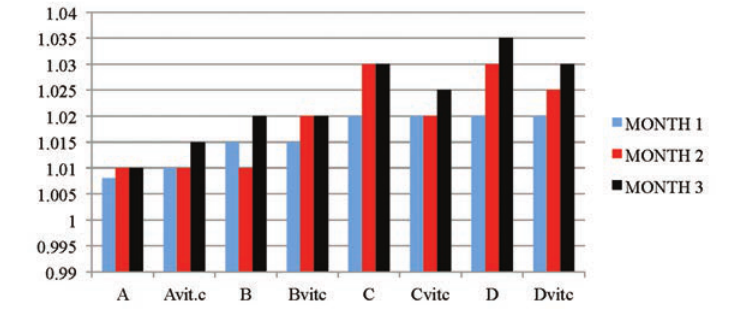
Figure 1. The mean urine specific gravity values of the different subgroups during the three months study period.